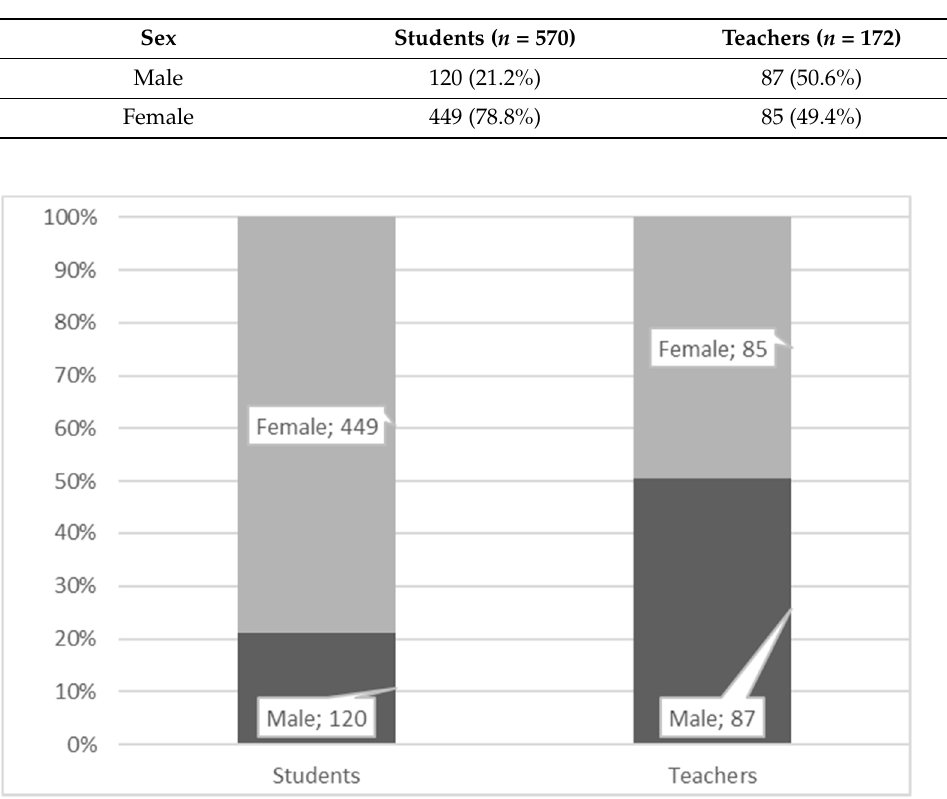
Figure 1. Students and teachers, by sex.